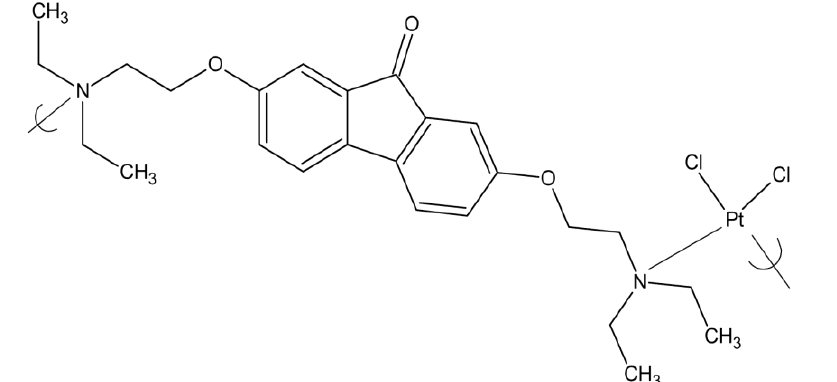
Figure 10. Repeat unit for the product of potassium tetrachloroplatinate II and tilorone.